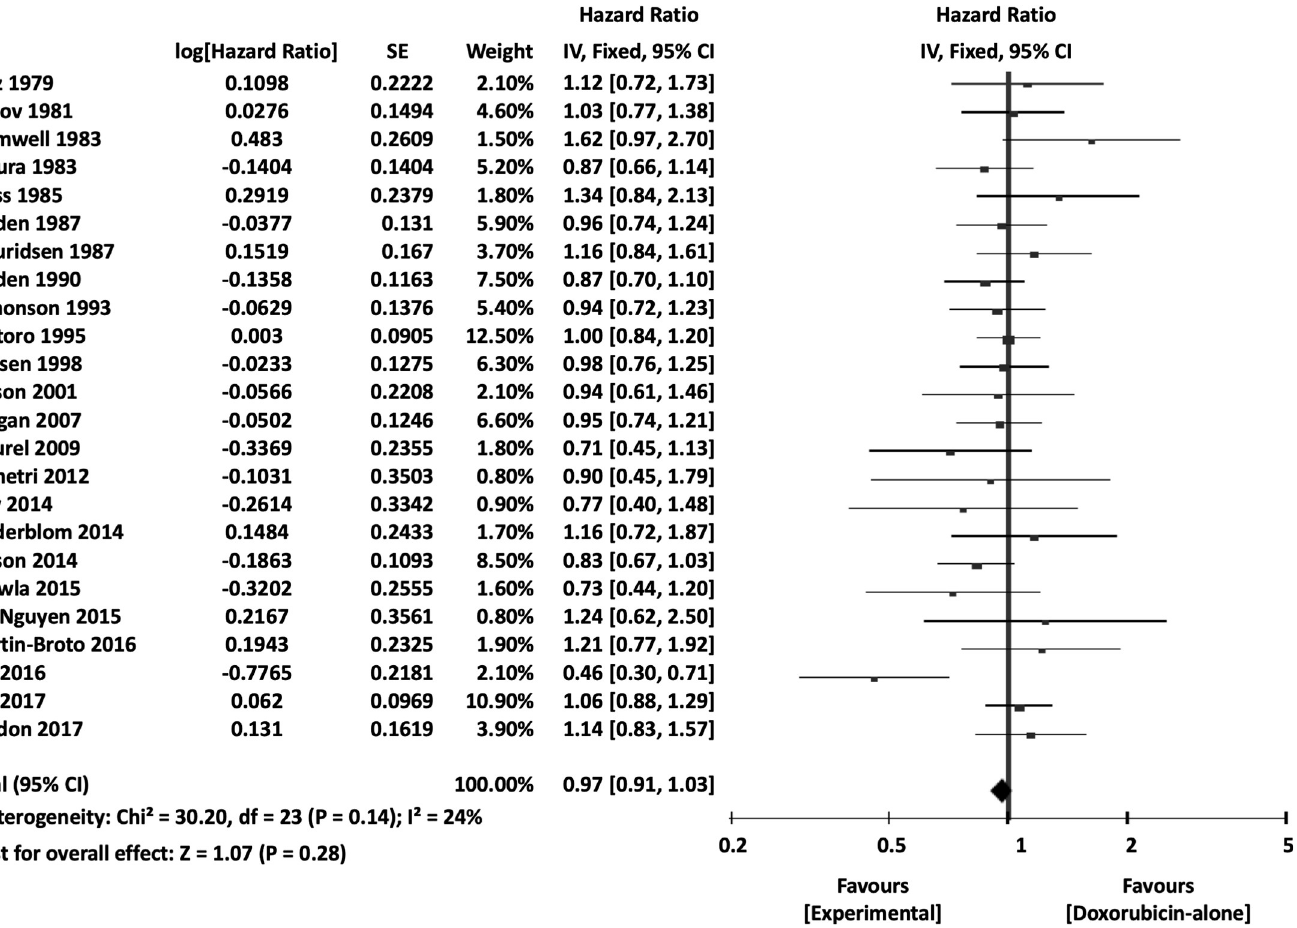
Fig 5. Comparisons of doxorubicin alone vs experimental chemotherapy: Forest plots of overall survival. M-H, Mantel-Haenszel; CI, confidence interval.